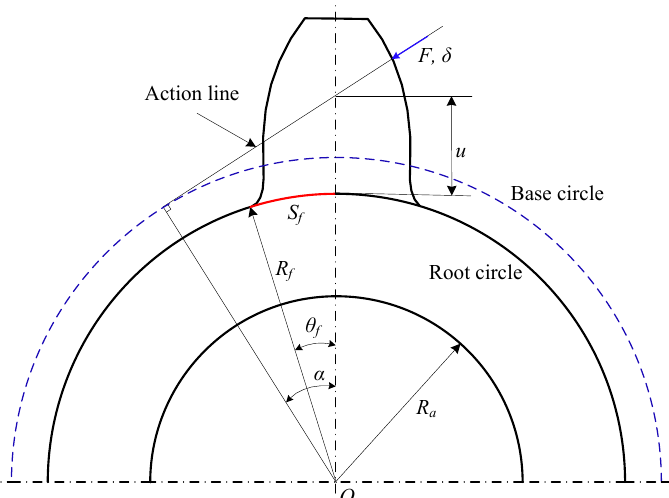
Figure 1. An elastic tooth subjected to a force F.